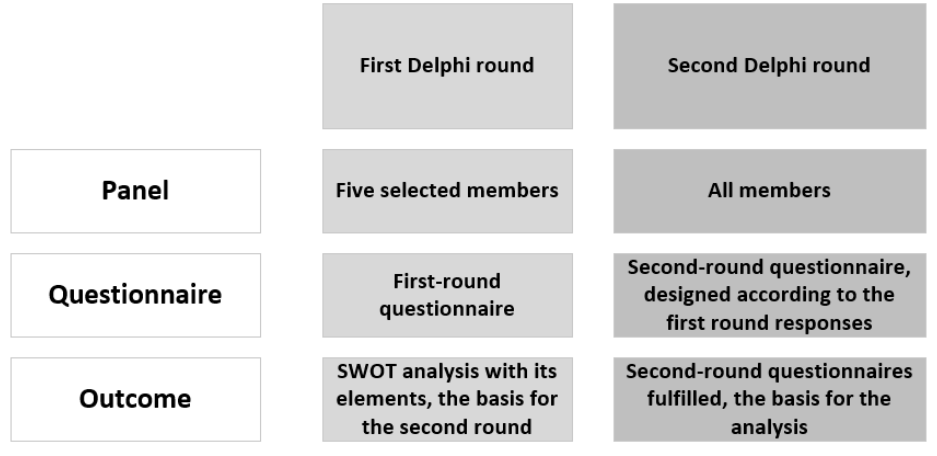
Figure 5. The schema for Delphi rounds.